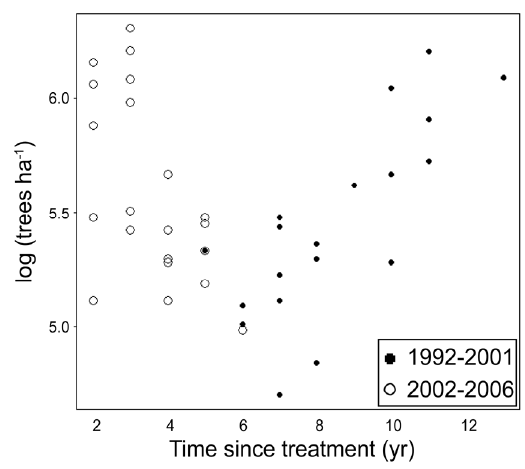
Figure 8. Stand density at the time of sampling for treatments sampled in both forest types. Figure includes data from sites located on land managed by the US Forest Service only. Symbol color represents the period in which forest thinning